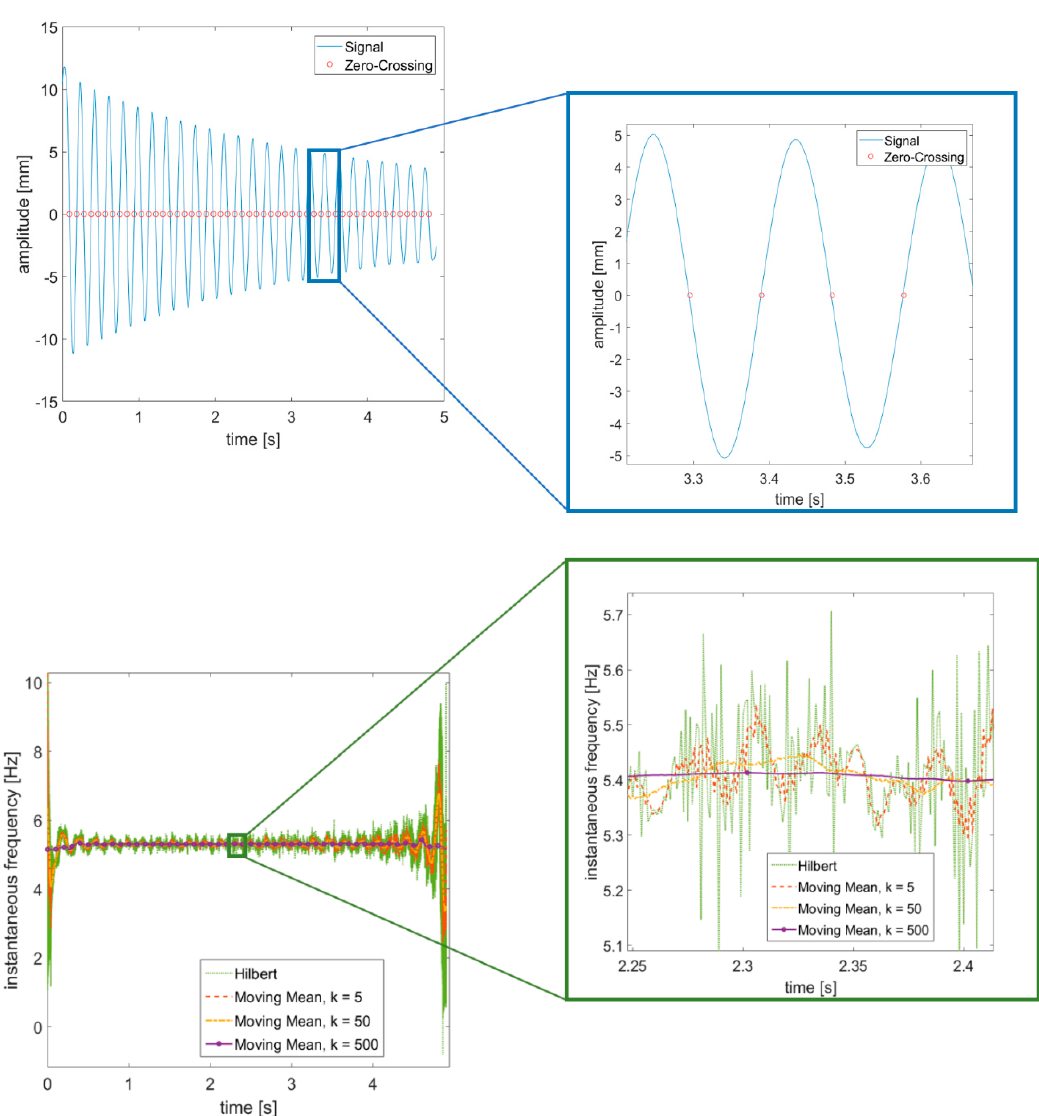
Figure 5. Estimation of instantaneous frequency (top) through zero crossing. Hilbert Transform is also shown for comparison, with a zoom (bottom left and bottom right, respectively). Same example as in Figure 4.